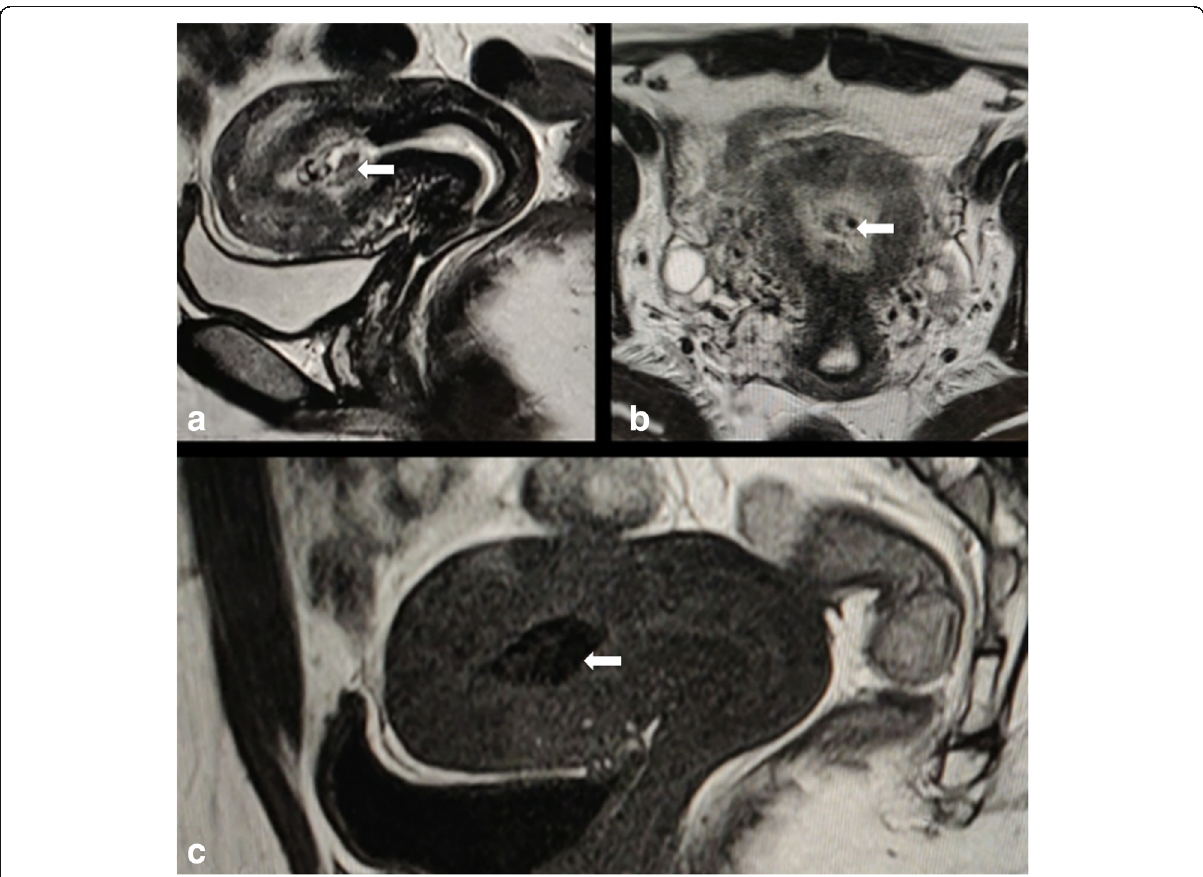
Fig. 4 Fast spin echo T2W sagittal ( a ) and axial ( b ) images of uterus in a 29-year-old infertile patient reveal patchy areas of hypointensity (arrows) within the endometrial canal in the uterine body. T1W sagittal ( c ) image reveals markedly hypointense and thick endometrial signal (arrows) compared to the myometrium. Subsequent HPE proved the diagnosis of